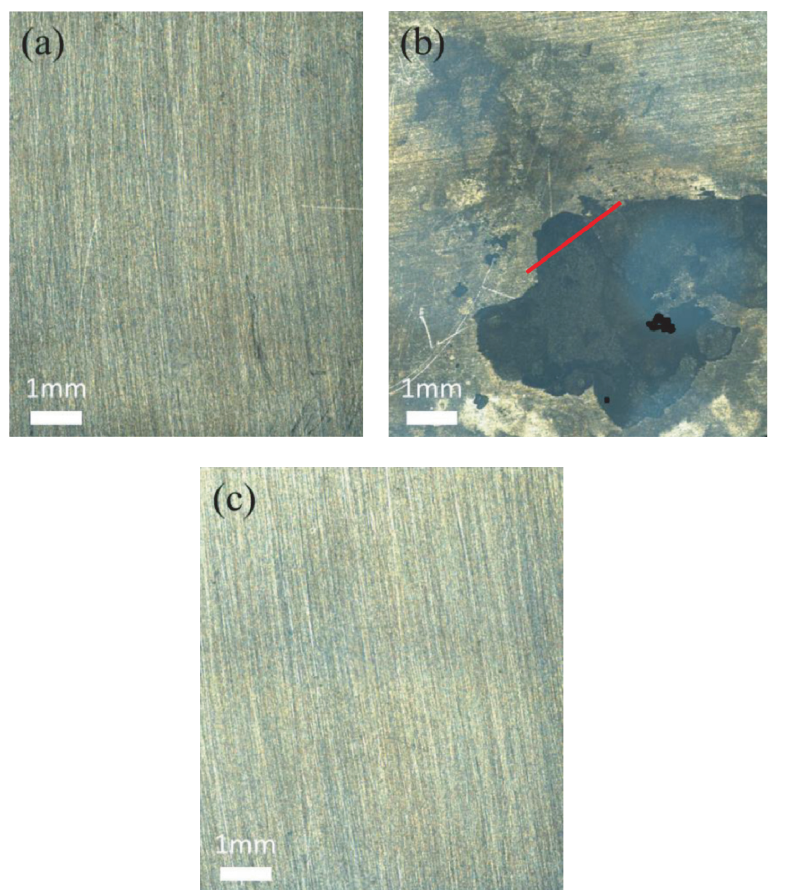
Figure 2: Surface images of 3 stainless steel types after 7-day incubation: (a) 304 SS, (b) 410 SS, and (c) 2205 SS. Note: red bar indicates IFM scan path in Figure 3(b).